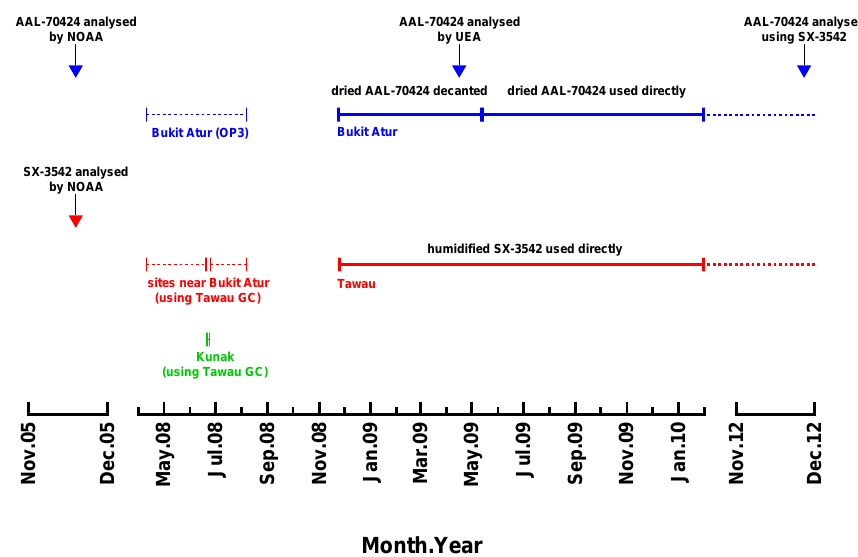
Figure 2. Timeline plot showing calibration comparisons and data coverage for the two sites. The solid blue line shows the data coverage for Bukit Atur and is divided into two periods where different calibration cylinders were used (decanted AAL-70424 from November 2008 to May 2009 and AAL-70424 used directly from May 2009 onwards). The solid red line shows the data coverage for the Tawau site where a high-quality calibration cylinder (SX-3542) was used constantly. The arrows show times of the initial calibration by NOAA and the various times of comparisons made for the Bukit Atur site. Other measurement periods not used in this study are shown as dotted lines, including the deployment to Kunak (during the OP3 campaign) shown in